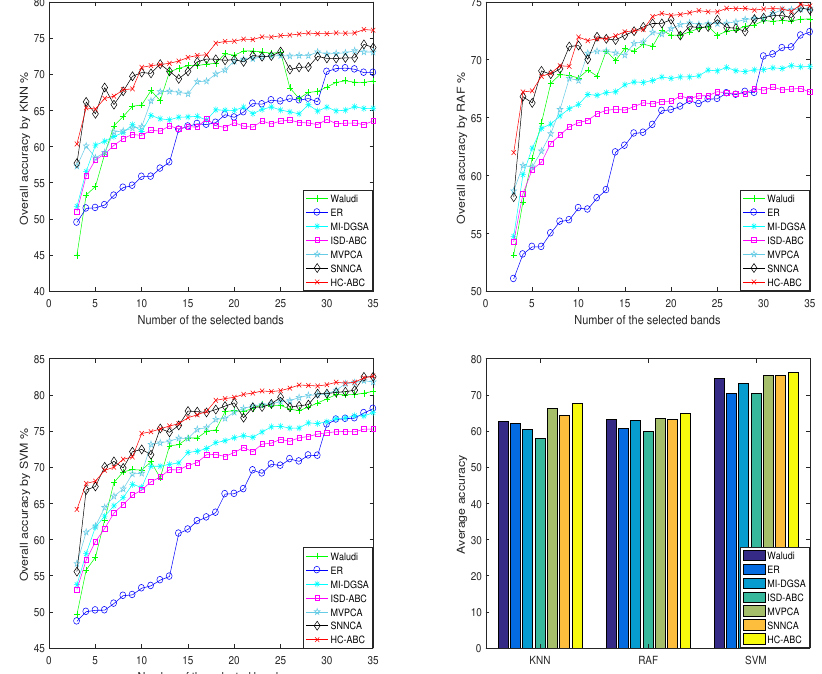
Figure 18. The results obtained by HC-ABC and the 6 comparison algorithms on Indian Pines.